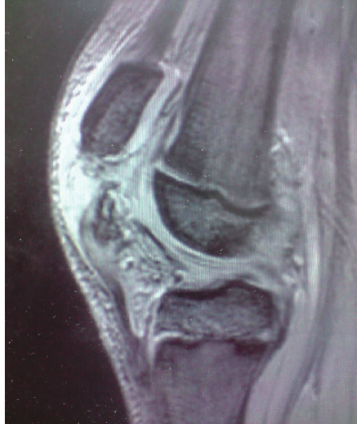
Figure 3: Sagittal T 2 MRI of the right knee.